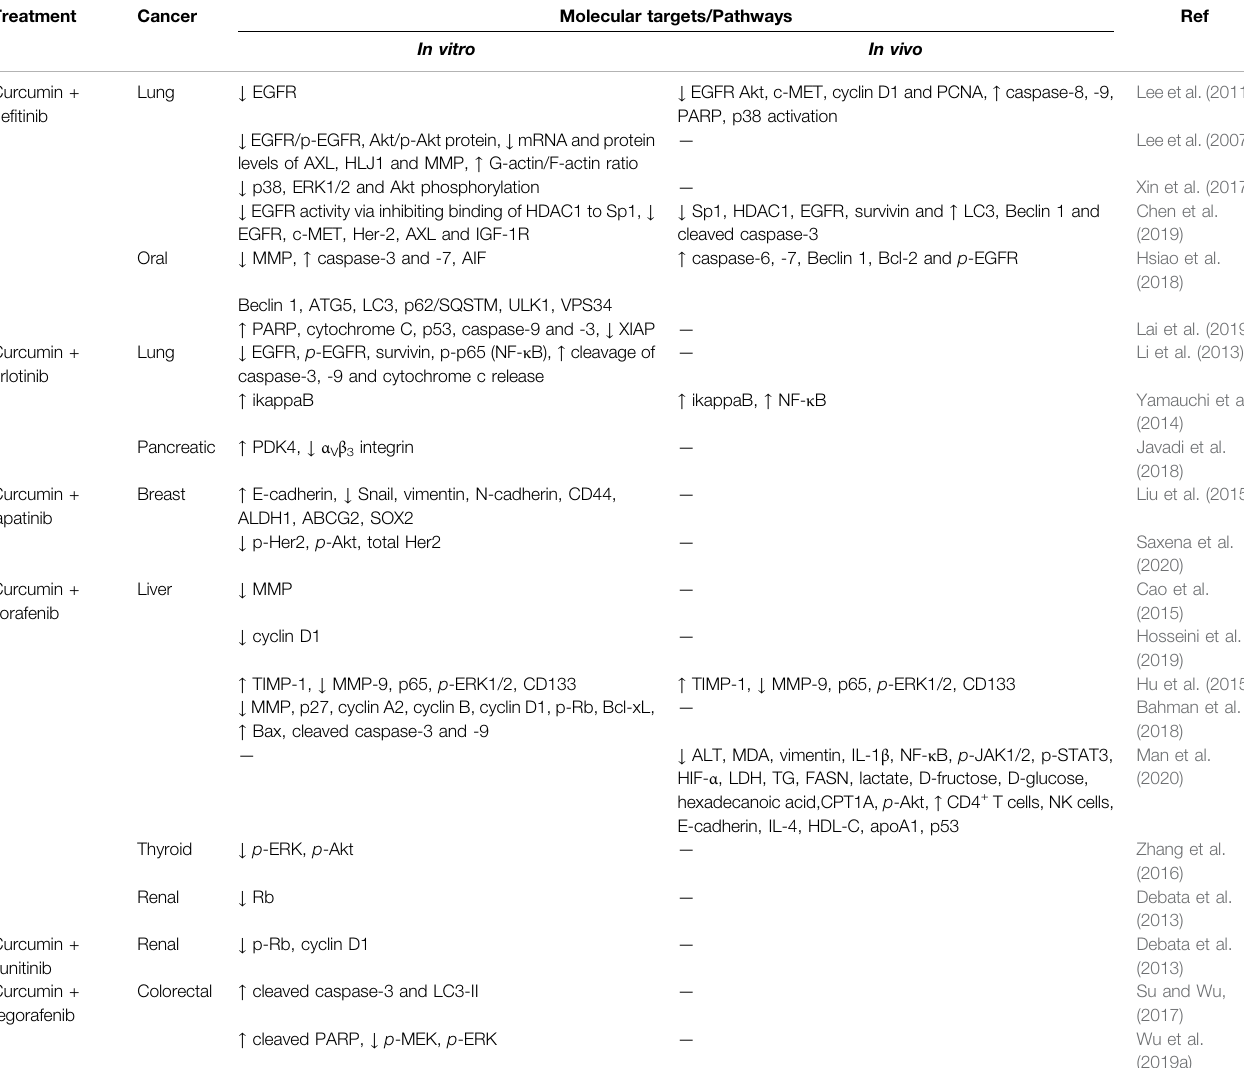
TABLE 2 | Summary of curcumin-RTKI combination studies. Treatment Cancer Molecular targets/Pathways Ref